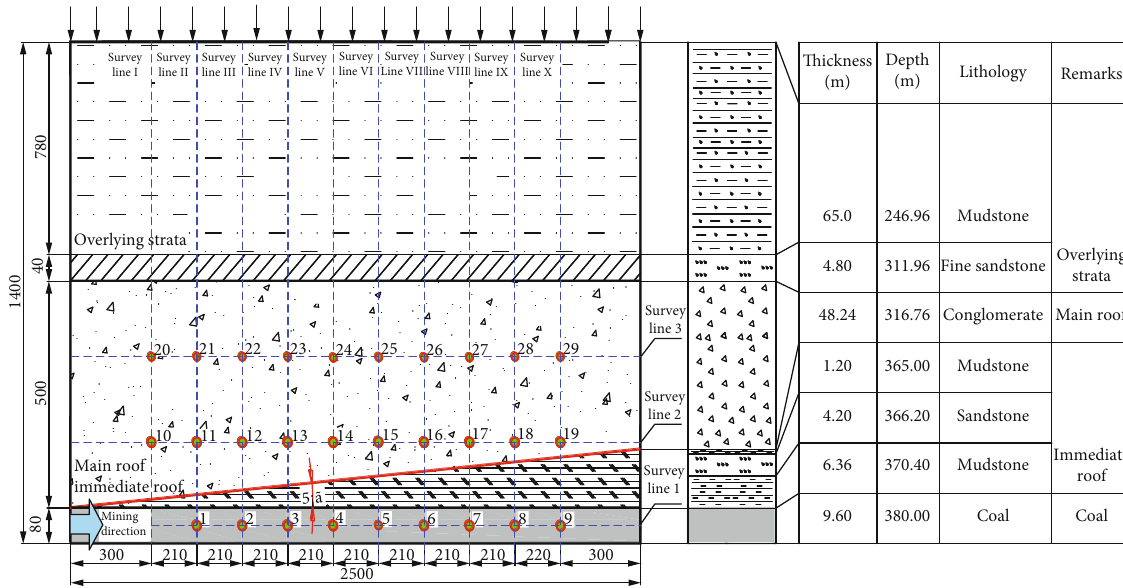
Figure 2: Stope model of extrathick coal seam mining under THR. Table 1: Principle for physical simulation model